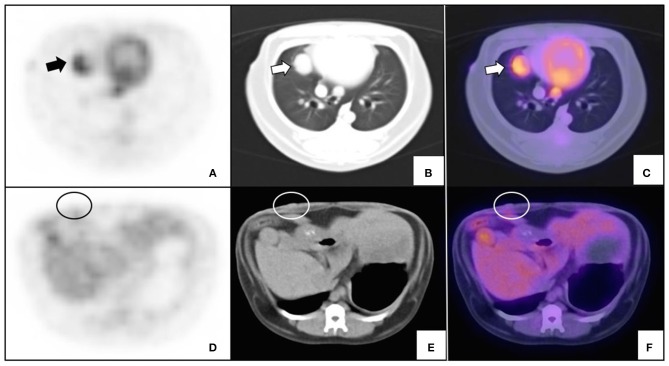
Variable glucose uptake of lung metastasis and primary malignant mammary tumor. An intact 15-year old female miniature Schnauzer with mammary cancer metastatic to lung. (A–C) Transverse slice of histopathologically confirmed lung metastasis (arrows); and (D–F) confirmed mammary cancer (circle). PET (A,D), CT (B,E), and fused imaging (C,F) are shown. SUVmax for lung metastasis was 2.14 and <0.7 for the smaller mammary tumor.